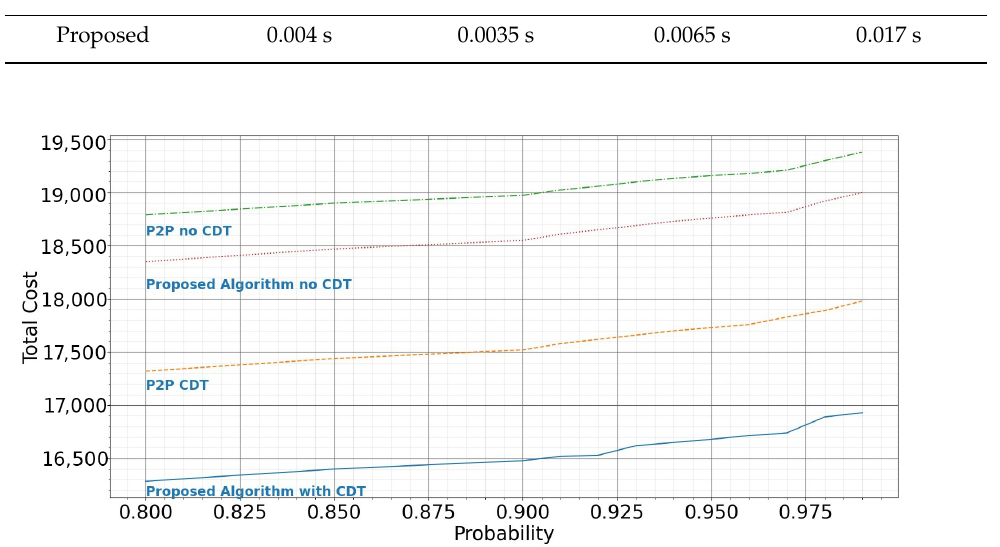
Figure 9. Total cost vs. probability of demand stochasticity violation.